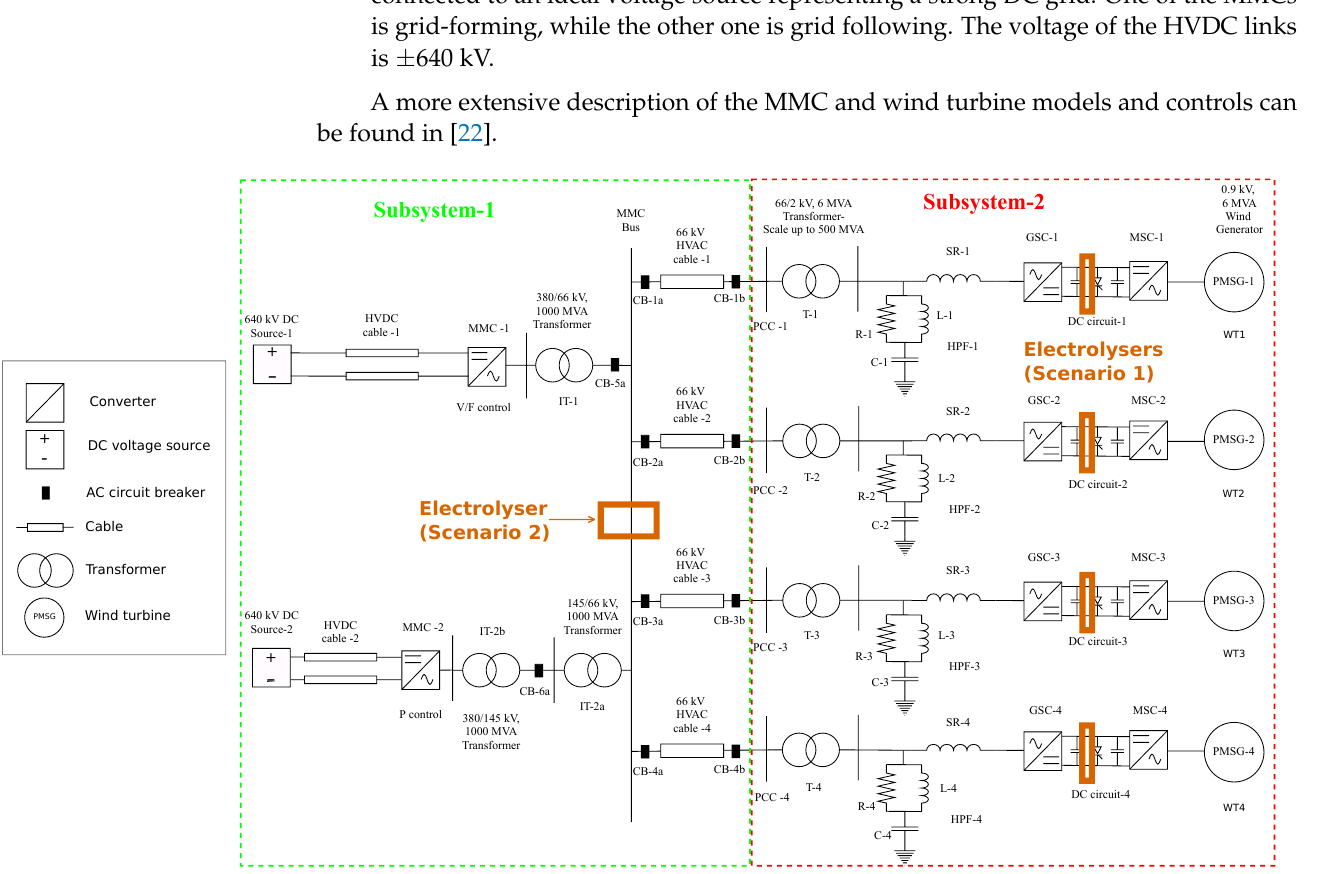
Figure 2. Baseline network model, indicating the locations for the connection of the electrolysers